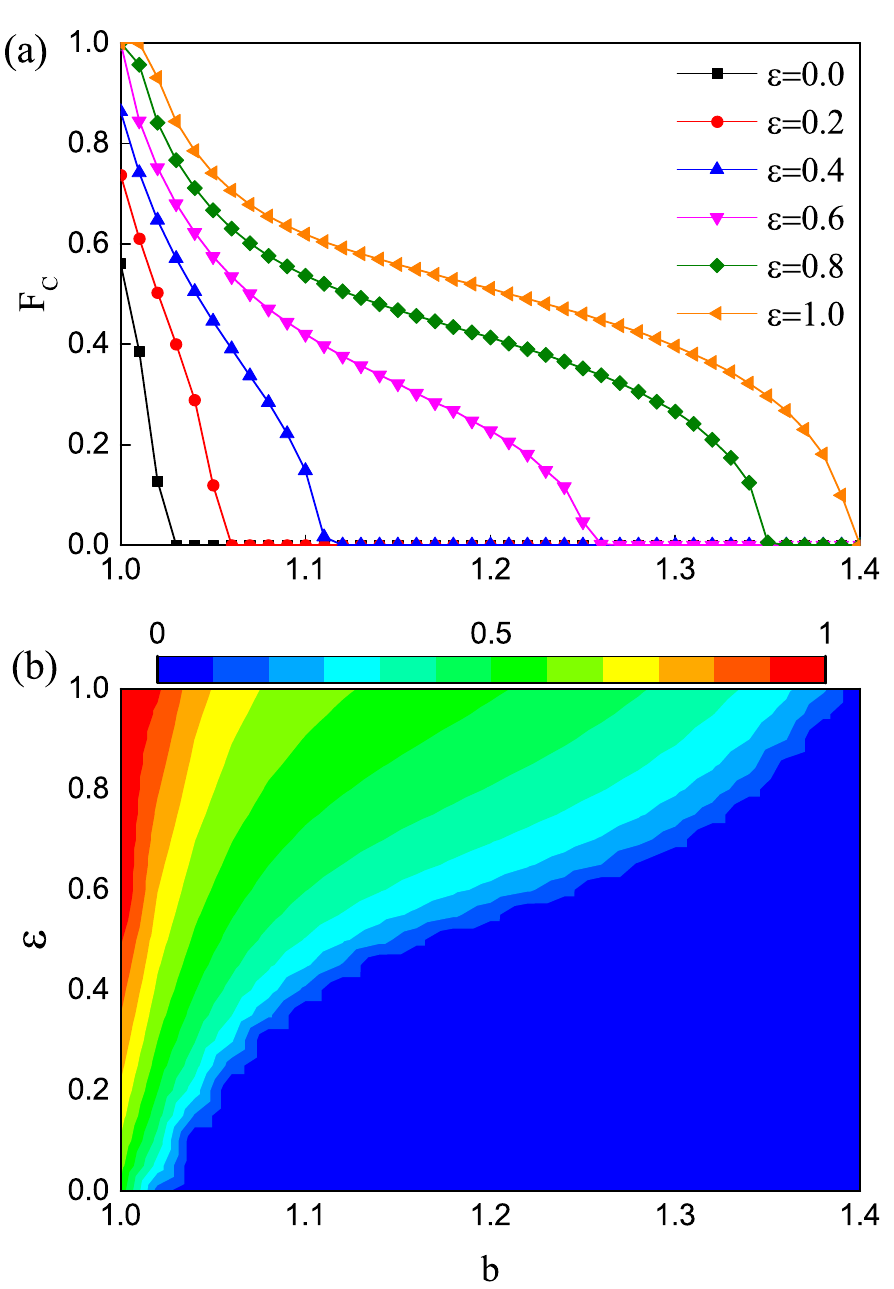
Fig 1. The effects of the strength of preferential selection ε and the temptation to defect b on the cooperation. (a) Fraction of cooperators F as a function of temptation to defect b with various values of the strength of preferential c selection ε . (b) Contour plot for the equilibrium F c on the ε − b parameter plane. defectors is better than that of the cooperators. Moreover, one can observe that a larger ε results in a higher F and a shorter period of END. In the subsequent EXP period, the time C series of F with different values of ε show two different trends. For ε > 0, F C increases before reaching a plateau. However, for ε = 0 (the random selection version), F tinues to decrease until reaching a dynamical equilibrium state.